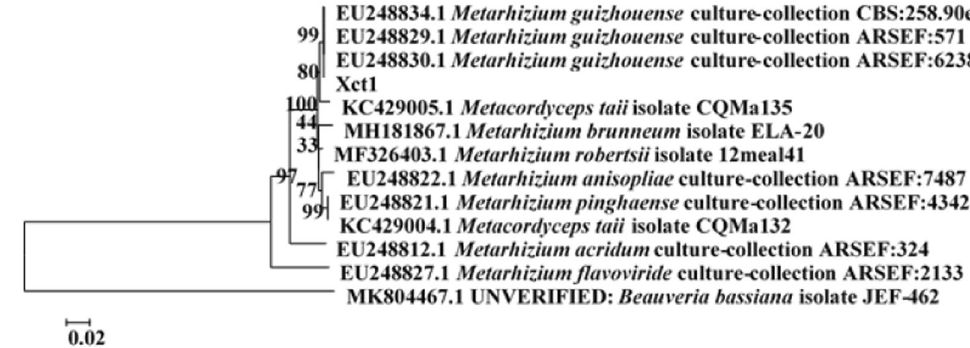
Fig. 4 Evolutionary tree of the Xct1 strain and Metarhizium anisopliae based on the beta-tubulin